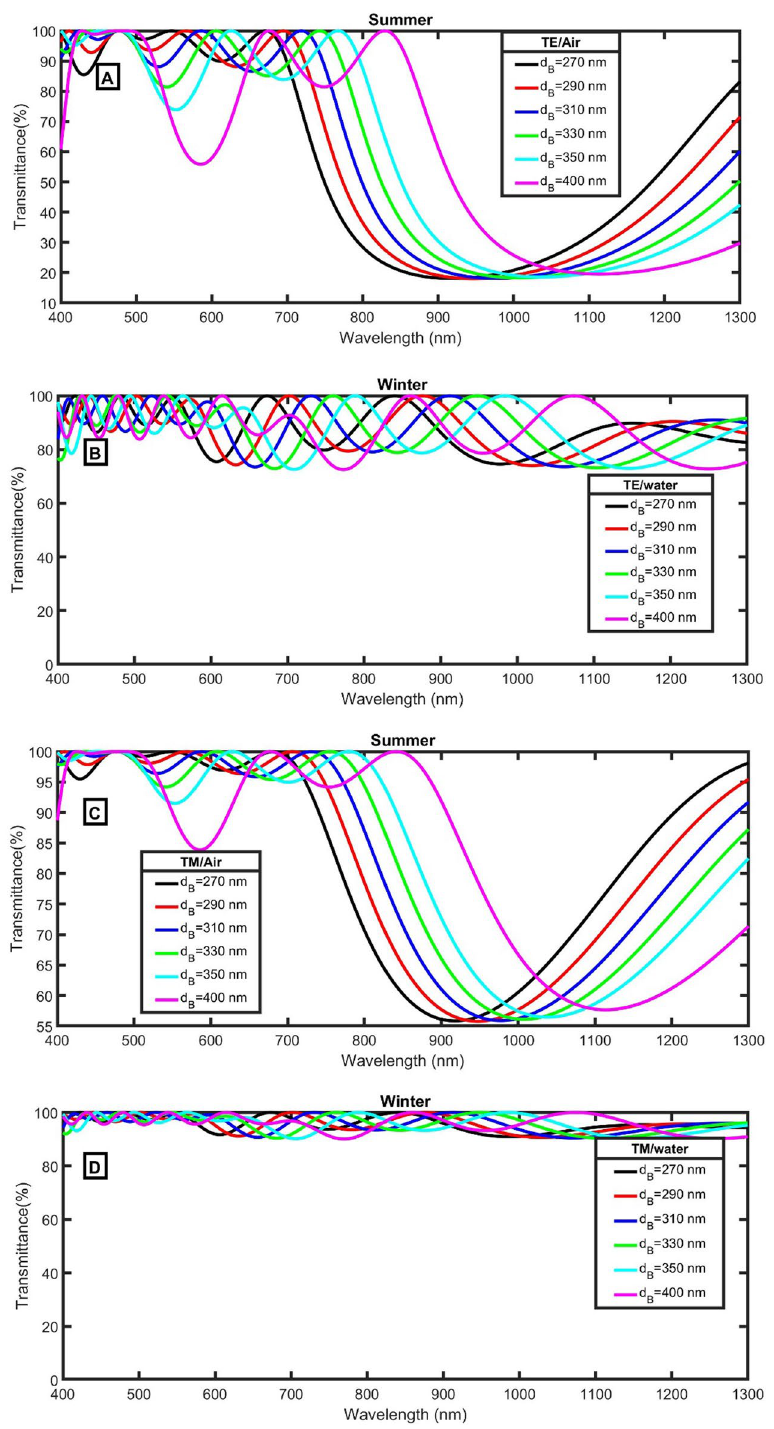
Figure 4. The transmittance of the proposed smart windows at 35 degrees and different values of d B ( A ) TE/Air, ( B ) TE/water, ( C ) TM/Air, and ( D )